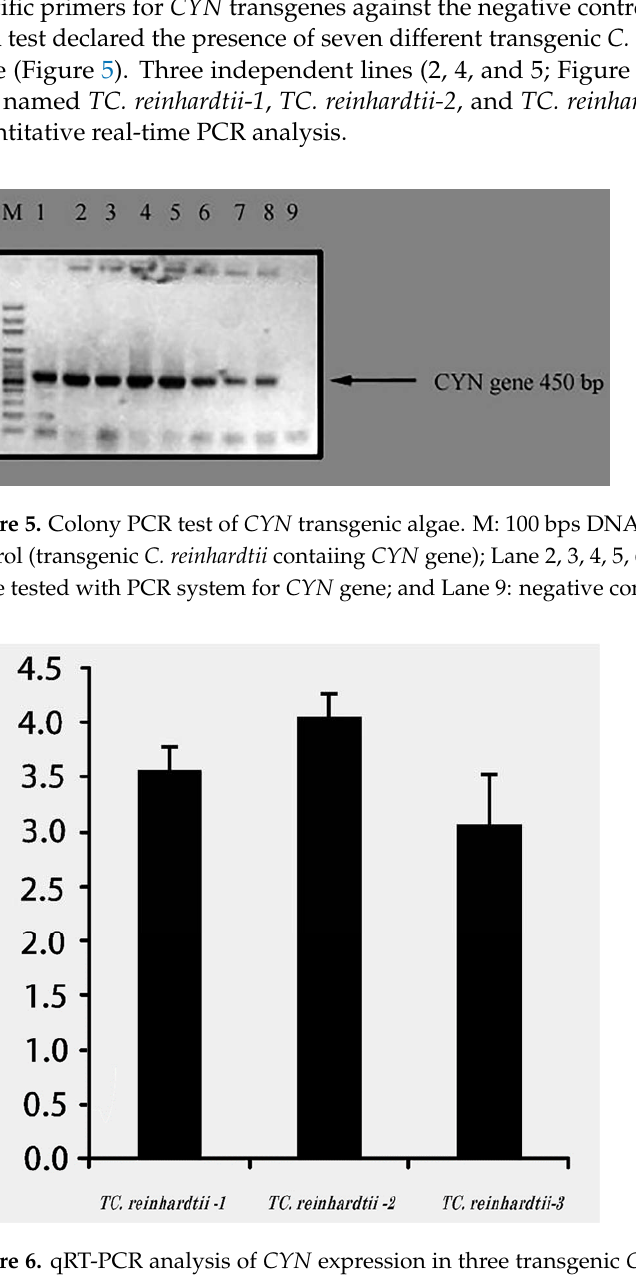
Figure 4. Colony PCR test for positive clones of Agrobacterium tumefaciens for pTRA ‐ K ‐ CYN. M: 100 bps DNA ladder; Lane 2, 3, 4, 5, 6: positive clones of A. tumefaciens ; Lane 1,7: negative clones of A. tumefaciens.